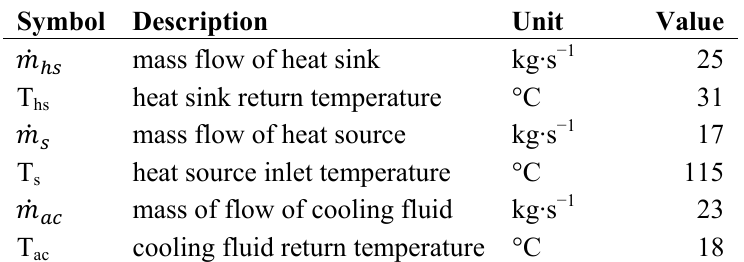
Table 2. Input data for the analytical model of the TCA unit.